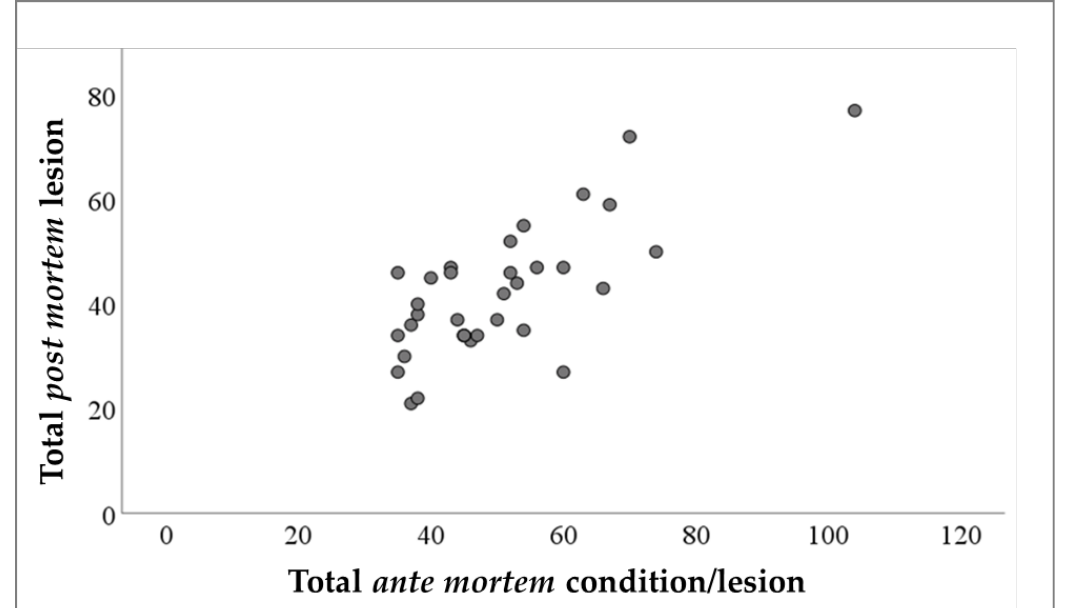
Figure 3. Scatter plot showing the association between the total ante-mortem and total post-mortem relief (OR = 1.007, 95%CI = 1.004 – 1.010; p < 0.001). The model included the batch size as an offset variable. Table 4. Relationship between the counts of post-mortem and ante-mortem relief observed in slaugh- tered pig batches ( N = 35). Poisson regressions were used to analyze the data. Univariable models were built, where each PM was included as a dependent variable and each AM was an independent variable. Only AM conditions with a prevalence >5% and PM with a mean prevalence >3% were examined. For all the models, batch size was included as an offset variable. PM * Lesion